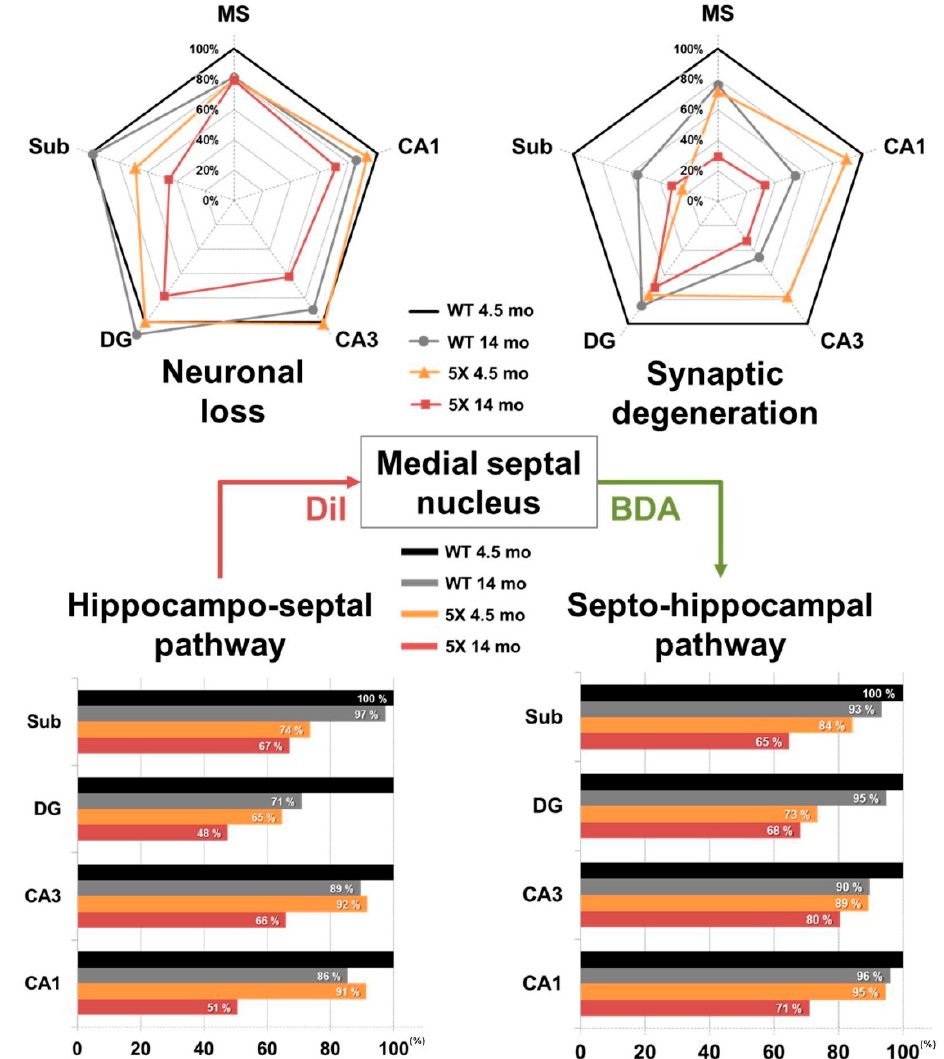
Figure 8. Schematic of the septo-hippocampo-septal (SHS) loop alterations in 5XFAD mice. The histological results in the MS and hippocampal formation were normalized to those of 4.5-month-old WT